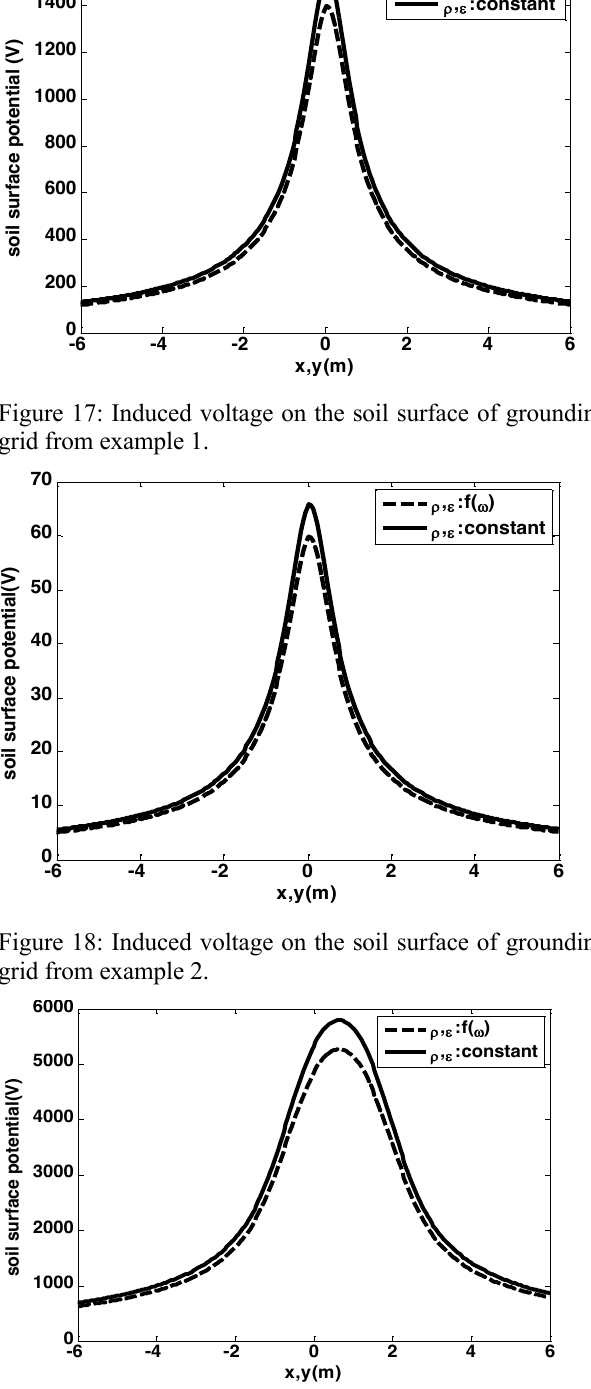
Figure 19: Induced voltage on the soil surface of grounding grid from example 3.